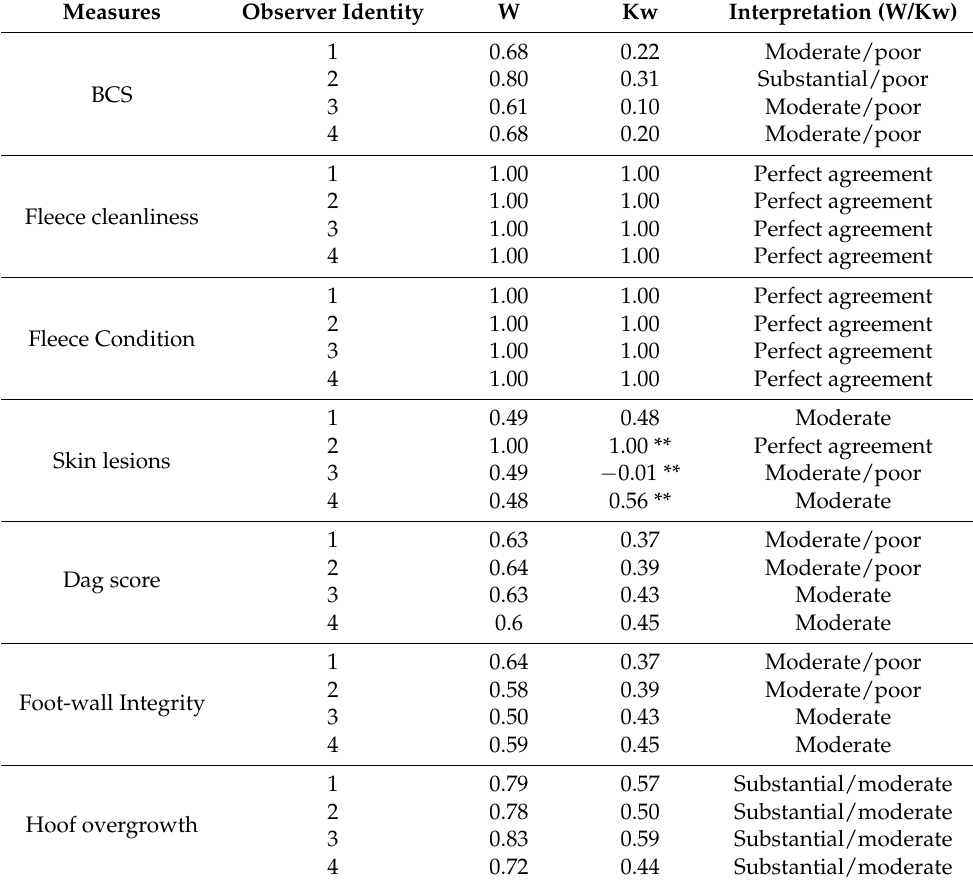
Table 3. Intra-observer agreement at